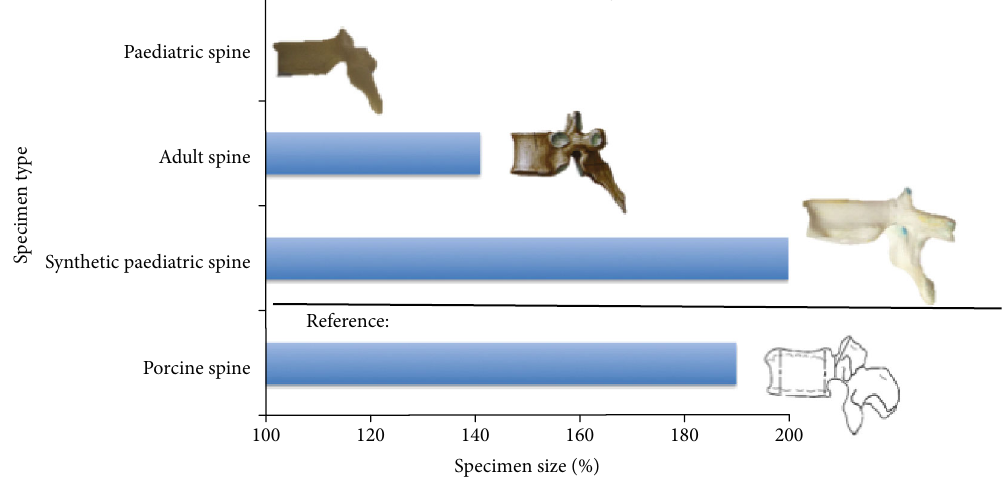
Figure 1: Size comparison among all spine models in this